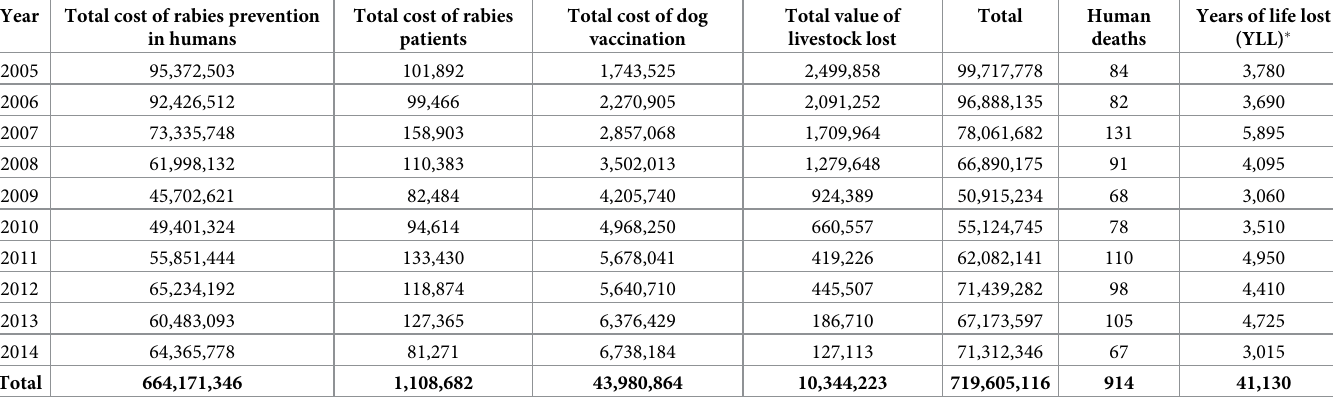
Table 11. Total annual cost (in 2017 USD) of rabies in Viet Nam from 2005 through 2014.